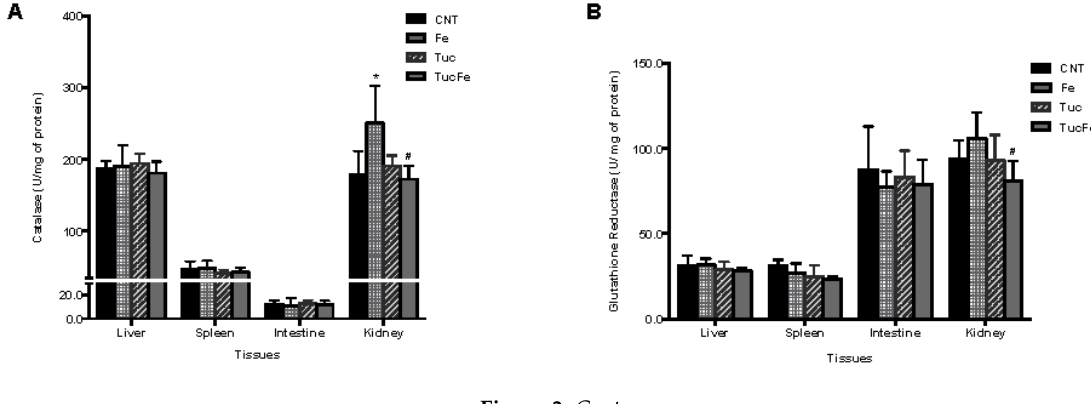
Figure 3. Figure 3. Cont. Figure 3. Cont.